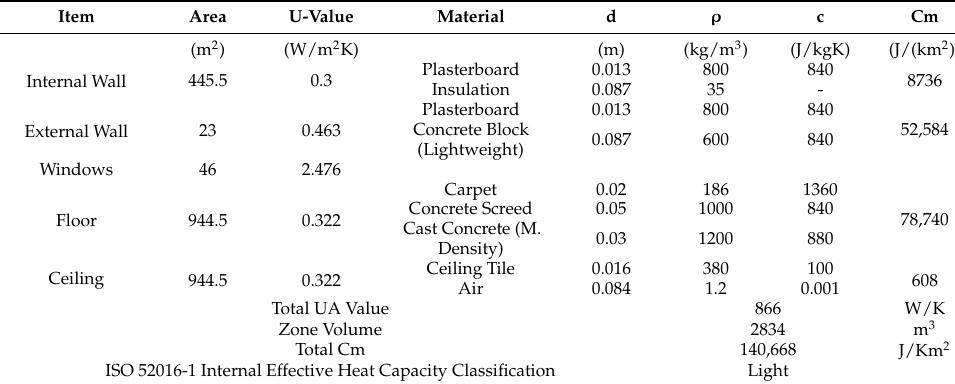
Table 2. Case study building information and